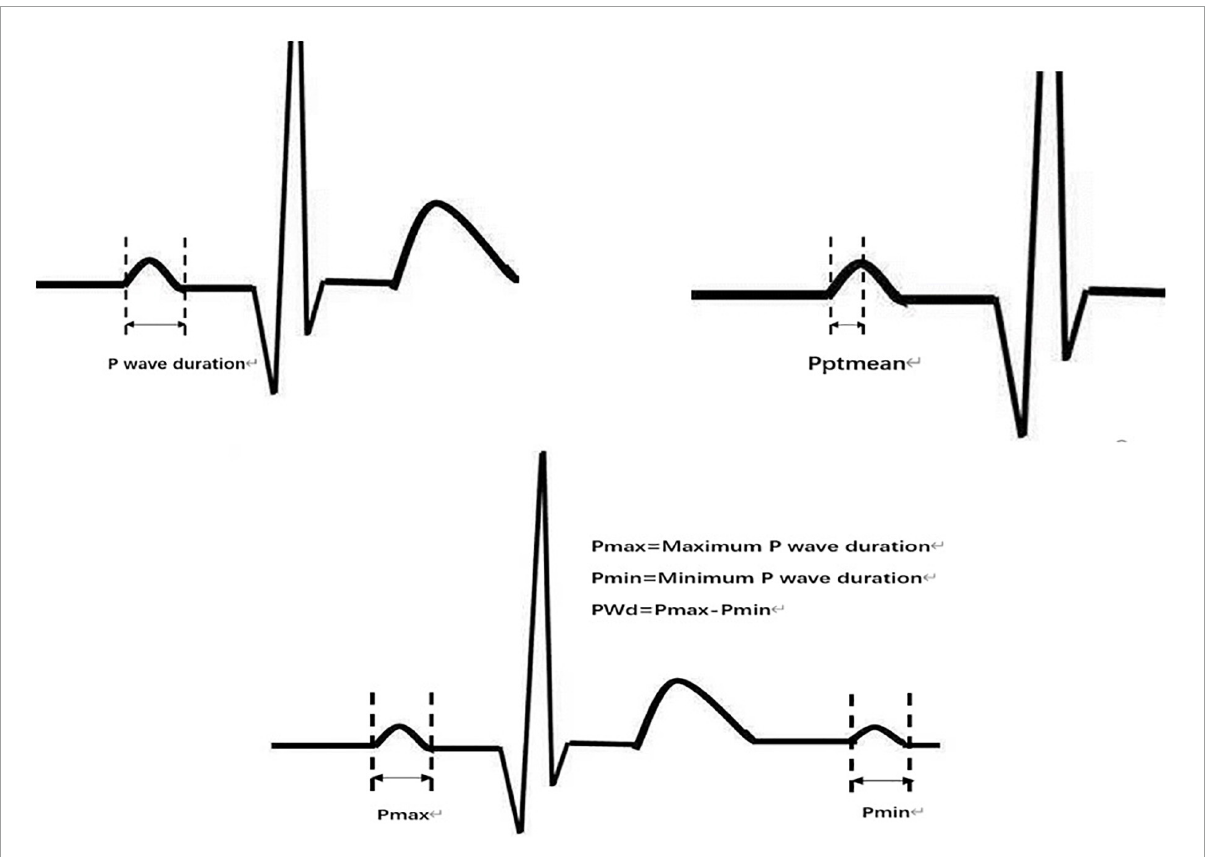
FIGURE2 Part of P-wave parameters. P wave duration, Pmax, Pmin, Pptmean,